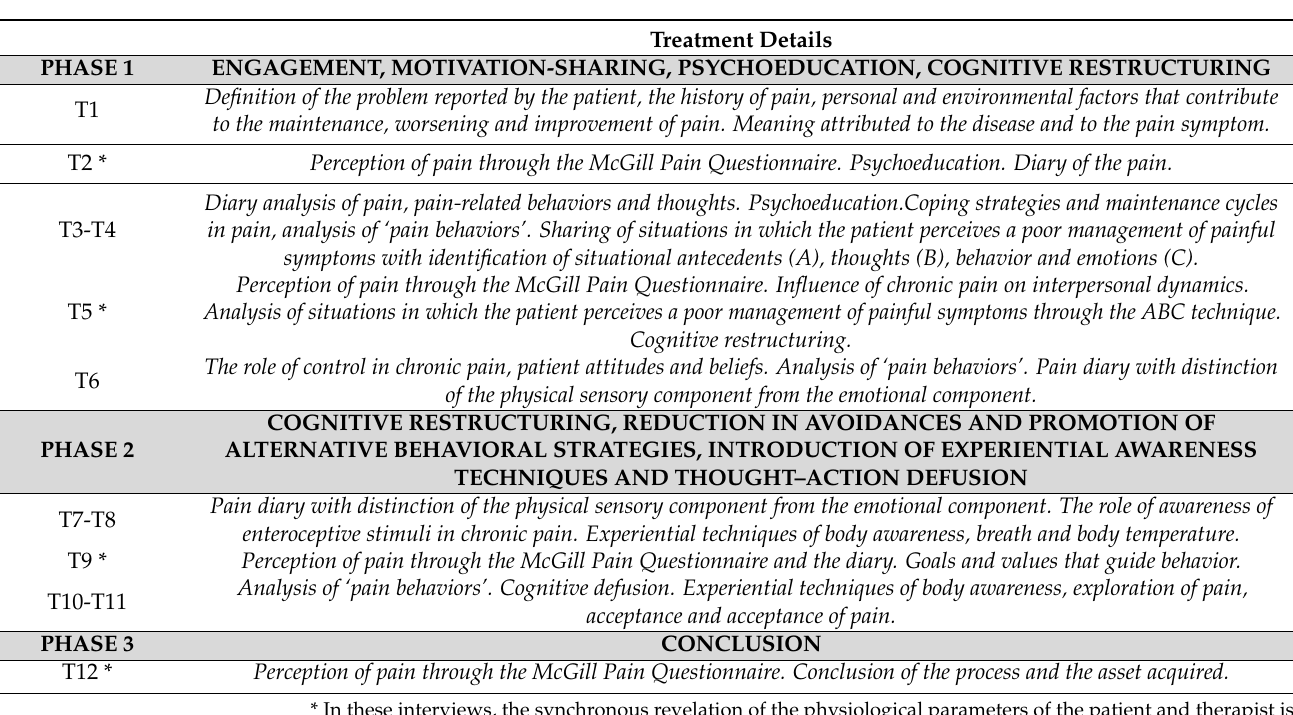
Table 2. INTEGRO